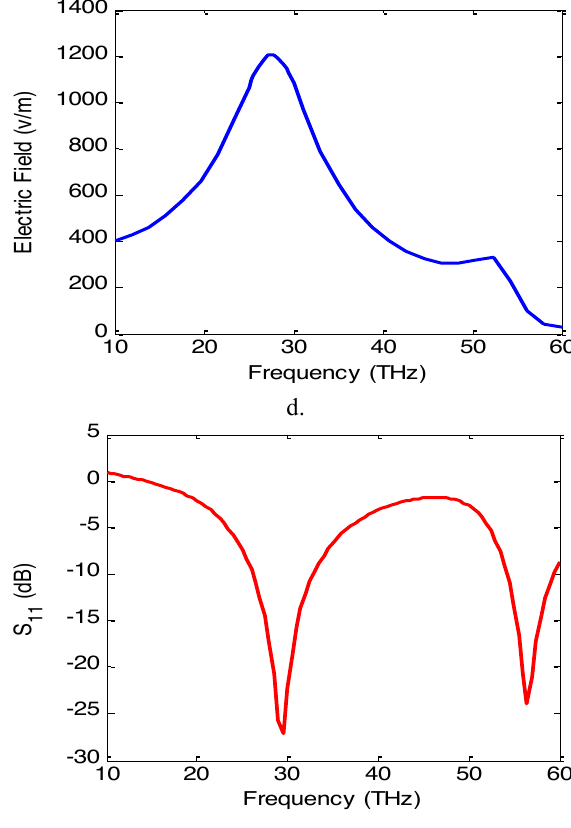
Figure 3. The electric field variation versus frequency for rhombic dipole IR-nanoantenna on a dielectric substrate with h=150 nm, w=5 µm, L=9 µm, t=50 nm. a. ψ =90 o , gap=100 nm, and different values of L , b. Ls=2.2 µm, s gap=100 nm and different values of tip angle ψ , c. Ls =2.2 µm, Ψ =20 o and different values of the gap, d. ψ =20 o , gap=10nm, and Ls=1.8 µm, e. The magnitude of the Reflection coefficient for the case d. Figure 3.a shows the variation of near electric field intensity versus frequency for different arm lengths at Ψ =90 degrees and gap=100 nm. An optimum rhombus side-length L =2.2 µm is achieved for maximum near field of 44.4 V/m s at 28.3 THz. In order to enhance the received electric field, the rhombus dipole tip angle is optimized to maximize the electric field across the gap. The variations of the electric field with frequency for different rhombus tip angles with L =2.2 µm, and gap=100 nm are shown in Fig.3b. s Decreasing the tip angle Ψ leads to increasing the charge field to 117.7 V/m for Ψ =20 degrees at L =2.2 µm, and s nm, 20 nm, 50 nm and 100 nm have been used with